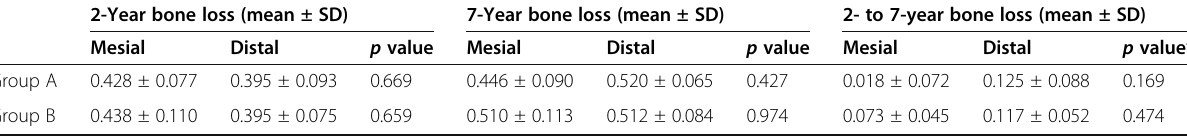
Table 7 Comparison between mesial and distal bone loss in the 2